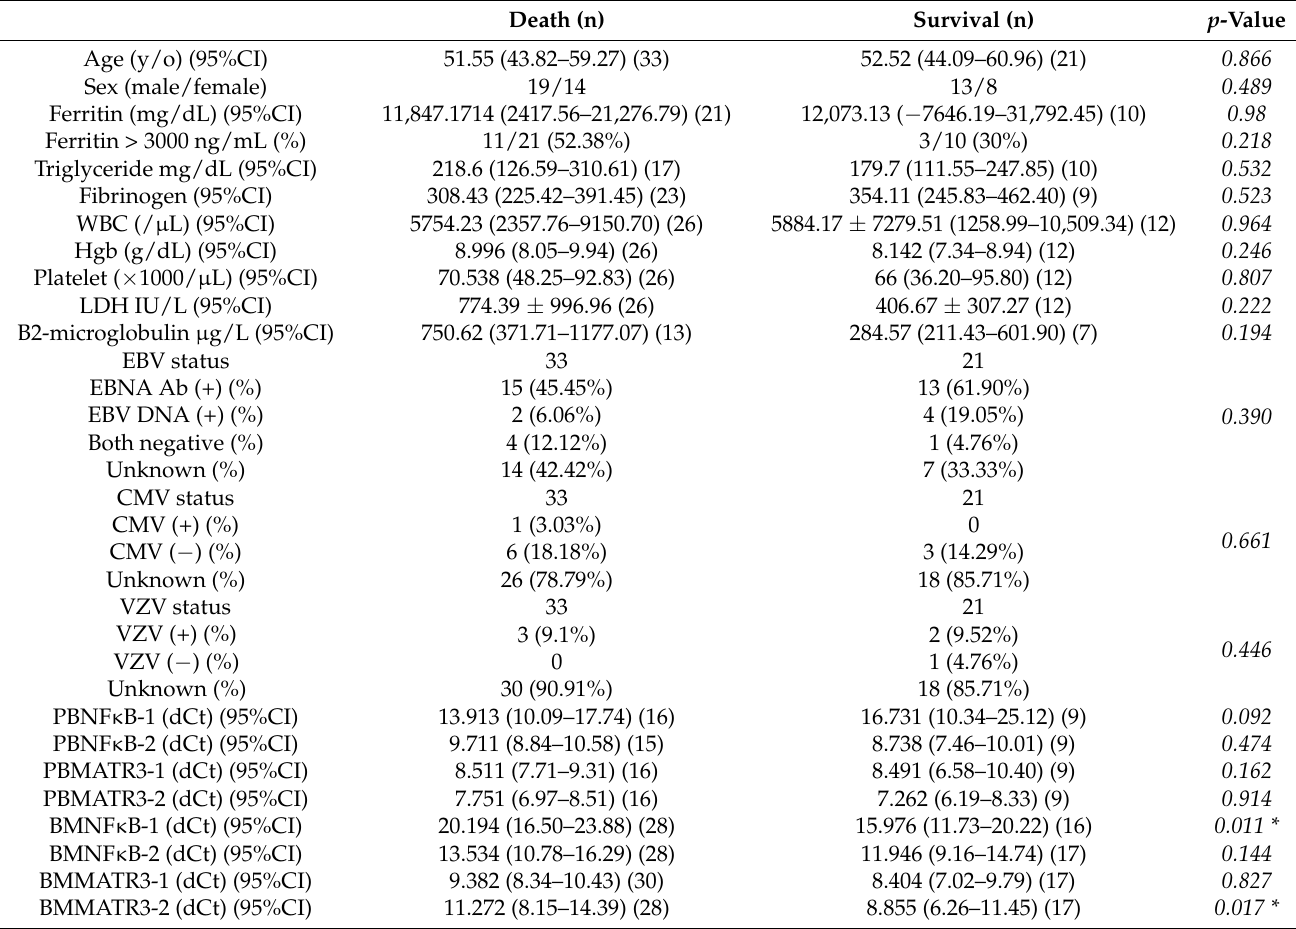
Table 1. Demographic characteristics of recruited patients base on survival. Death (n) Survival (n) p